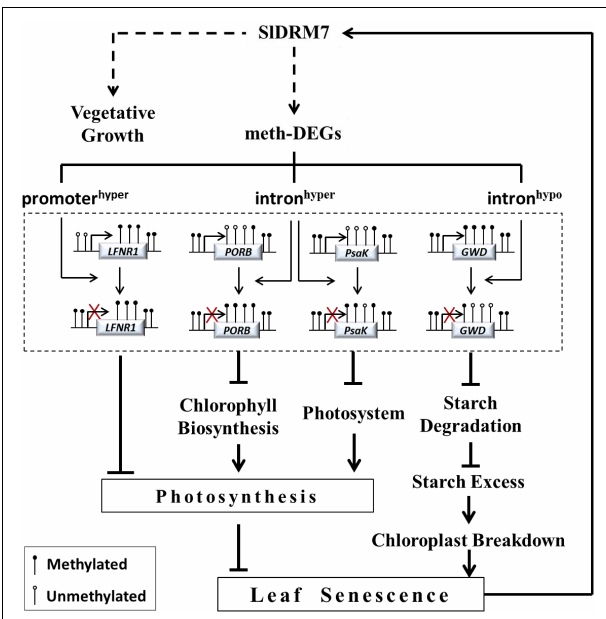
FIGURE 8 | A model for SlDRM7 epi-controls leaf chlorosis and senescence. SlDRM7-mediated DMRs affect gene expression, which is designed as meth-DEGs. Silencing of SlDRM7 influences DNA methylation in promoter and gene body, and leads to transcriptional inhibition of genes directly or indirectly as exemplified by SlLFNR1 , SlPORB , SlPsaK , and SlGWD . We hypothesized that these changes including promoter hypermethylation of SlLFNR1 , intron hypermethylation of SlPORB and SlPsaK, and intron hypomethylation of SlGWD resulted in their expression repression, which inhibited photosynthesis and starch degradation, eventually leading to leaf chlorosis and senescence. Conversely, leaf senescence can induce SlDRM7 , forming a feedback regulatory loop, to balance vegetative growth and